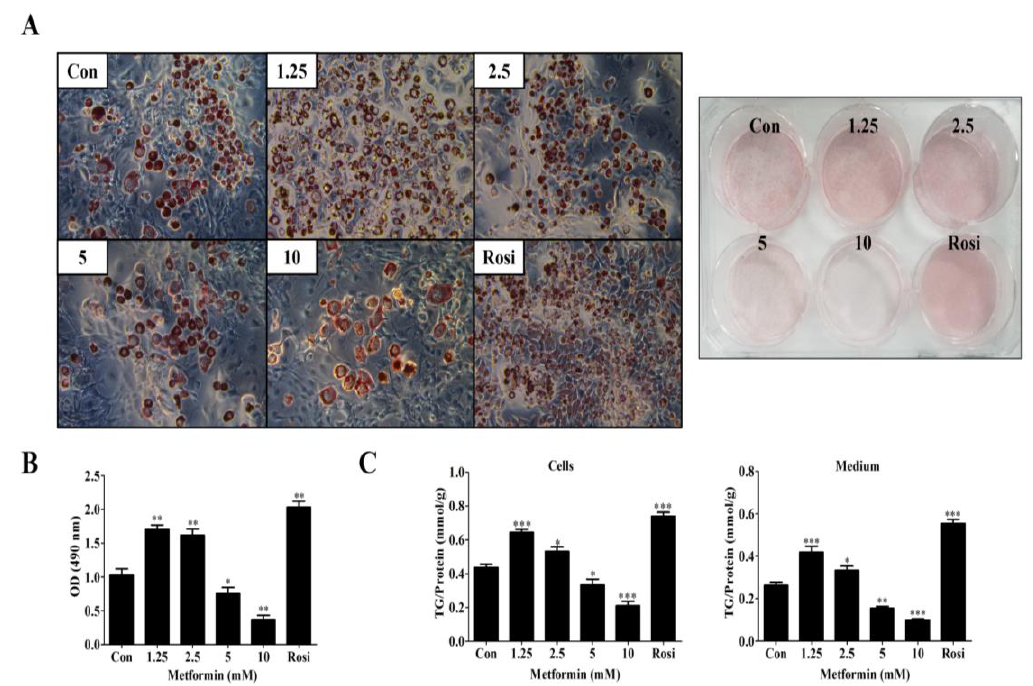
Figure 2. Effects of different concentrations of metformin (1.25 – 10 mM) on lipid accumulation in 3T3-L1 cells. ( A ) Effects of metformin on adipocyte formation at day 9 as determined by Oil Red O staining, 100×. Microscopic observation ( left ); 6-well plate ( right ); ( B ) Optical density (OD) of quantified Oil Red O staining in 3T3-L1 cells ( n = 3); ( C ) Effects of metformin on intracellular and extracellular TG contents at day 9 as determined by triglyceride GPO-POD (glycerophosphate oxidase-phenol aminophenazone) enzymatic assay. Results are normalized by protein concentration in cell lysates ( n = 3). The data represents the means ± SEM (standard error of mean) from three independent experiments. * p < 0.05, ** p < 0.01 and *** p < 0.001 as compared with DMI alone treated cells (one-way analysis of variance (ANOVA) with Dunnett’s correction).